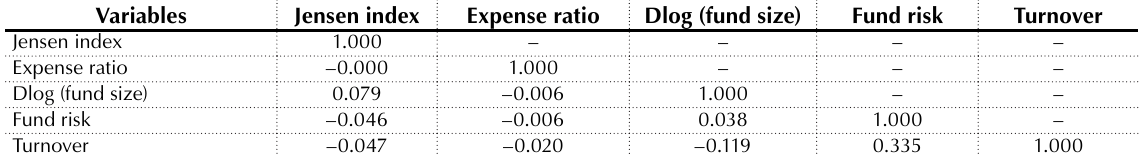
Table 7. Group C correlations